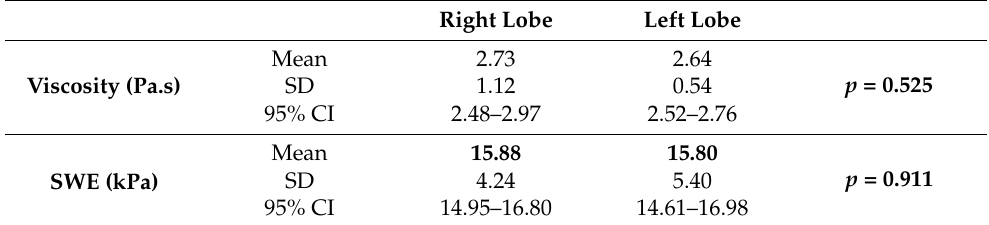
Table 2. Mean viscosity and stiffness values of the right and left thyroid lobes. Right Lobe Left Lobe